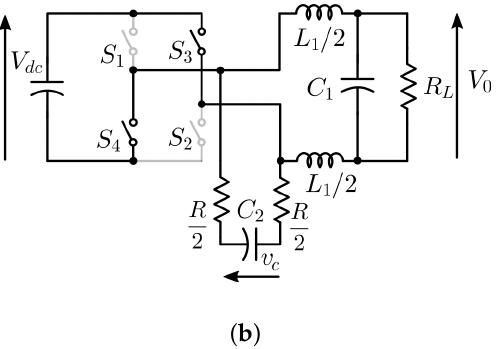
Figure 3. Equivalent circuit of the system when ( a ) S 1, S 2: ON and ( b ) S 1, S 2: